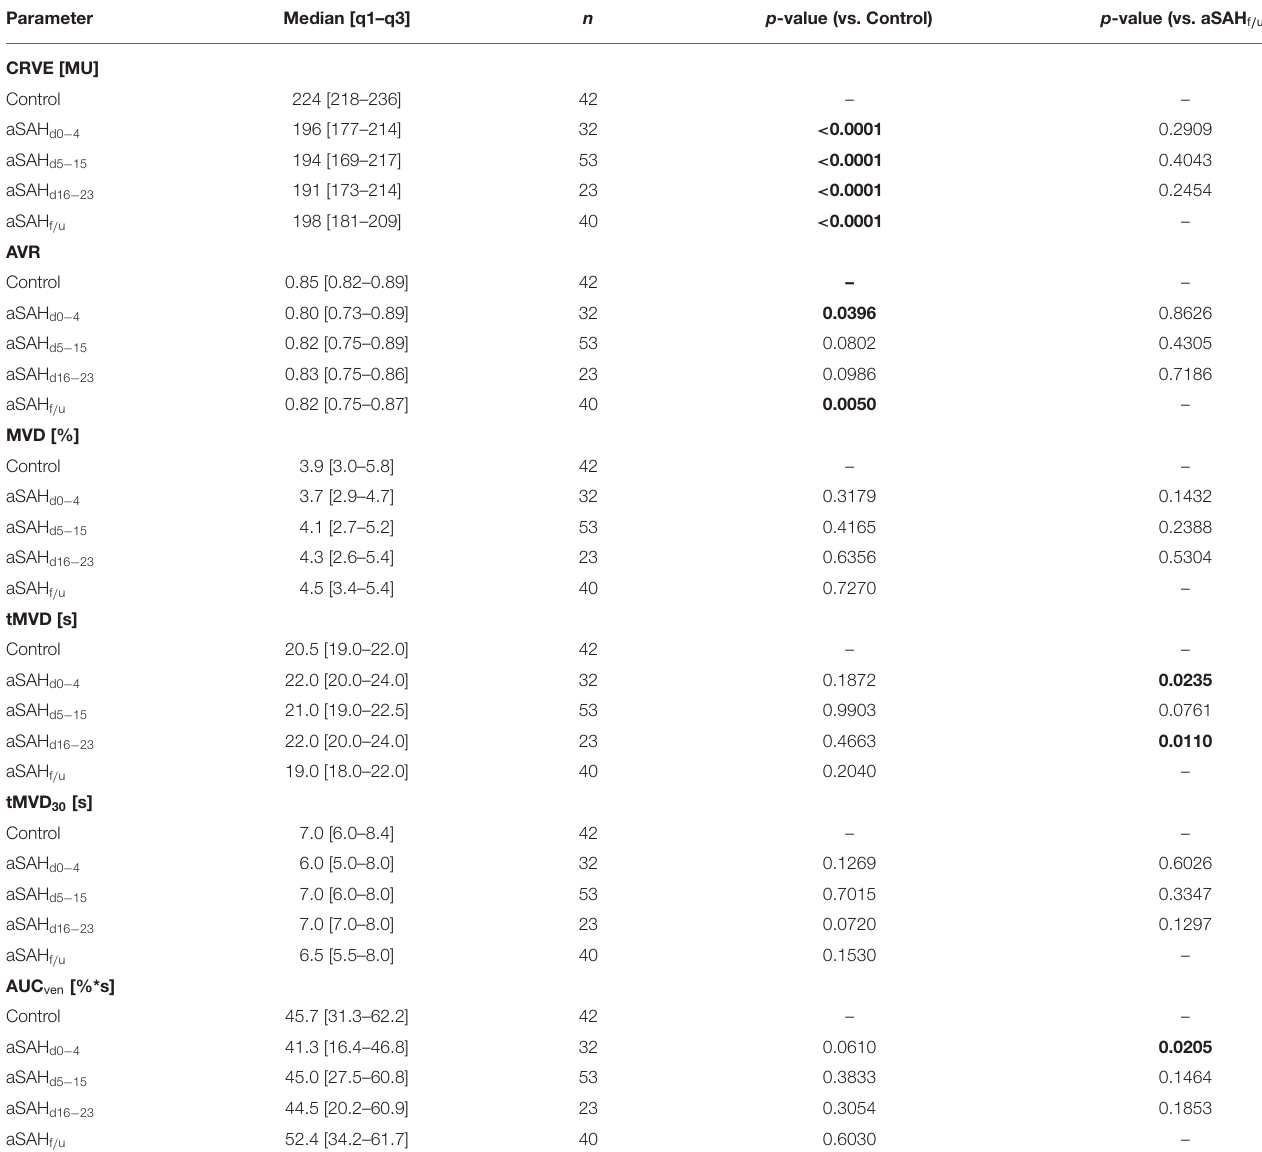
TABLE 3 | Venous RVA parameters in control and aSAH patients. Parameter Median [q1–q3] n p -value (vs. Control) p -value (vs. aSAH f / u